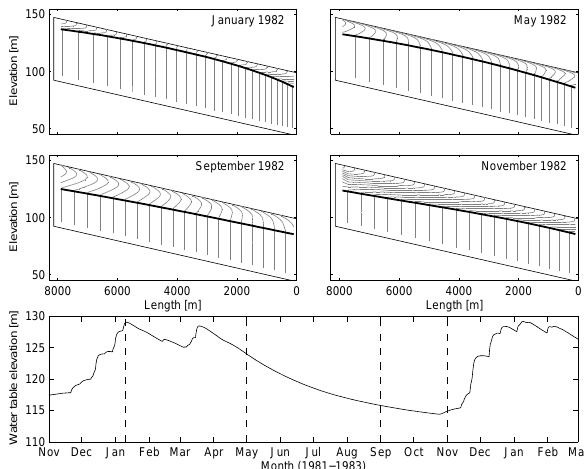
Fig. 4. Hydraulic head distribution in the unsaturated and saturated zones, through a typical year (note exaggerated vertical-scale in transect plots).